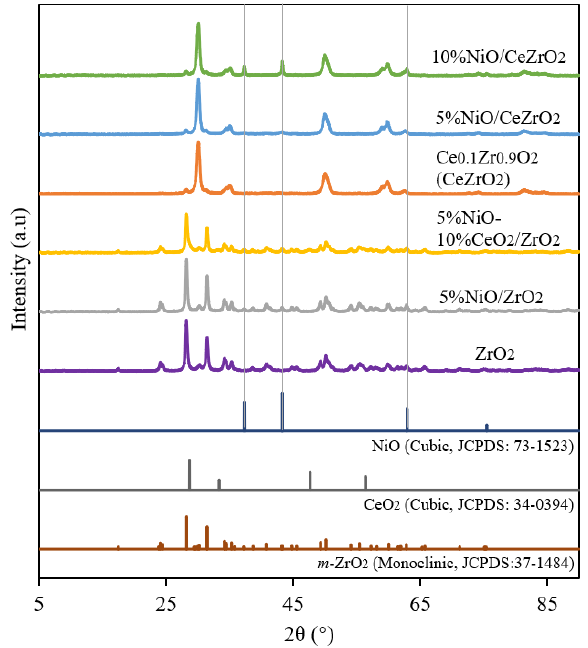
Figure 1. XRD pattern on a ceria-zirconia-supported nickel catalyst.